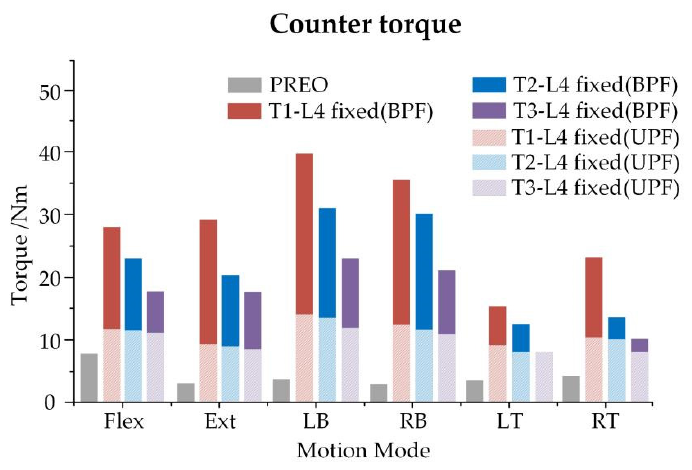
Figure 10. Counter torque on C6 in the different surgical procedures.